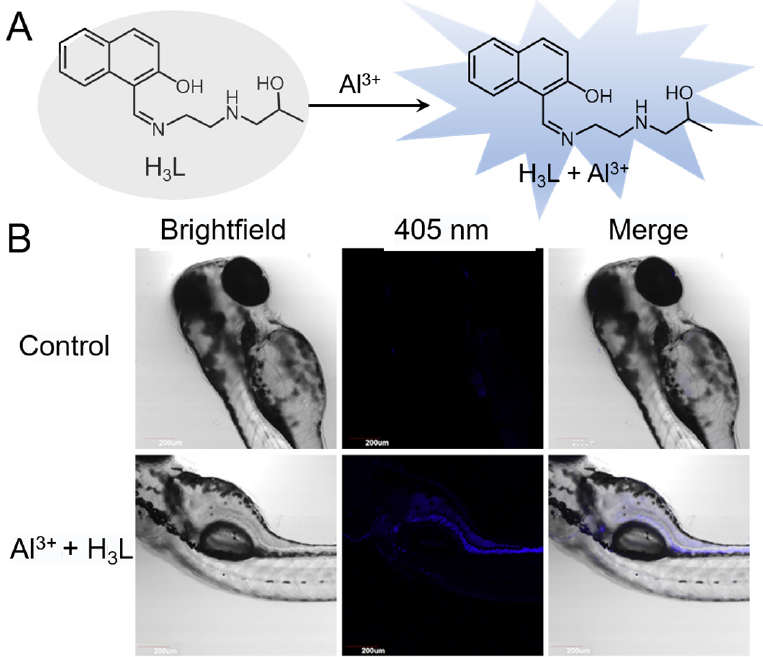
Figure 14. ( A ) Al 3+ fluorescent probe (H3L) for the in vivo detection of Al 3+ . ( B ) Confocal fluorescence Al 3+ imaging of 3-day-old zebrafish larvae stained with the Schiff base ligand H3L. Reproduced from [186] with permission from Elsevier, copyright 2018.